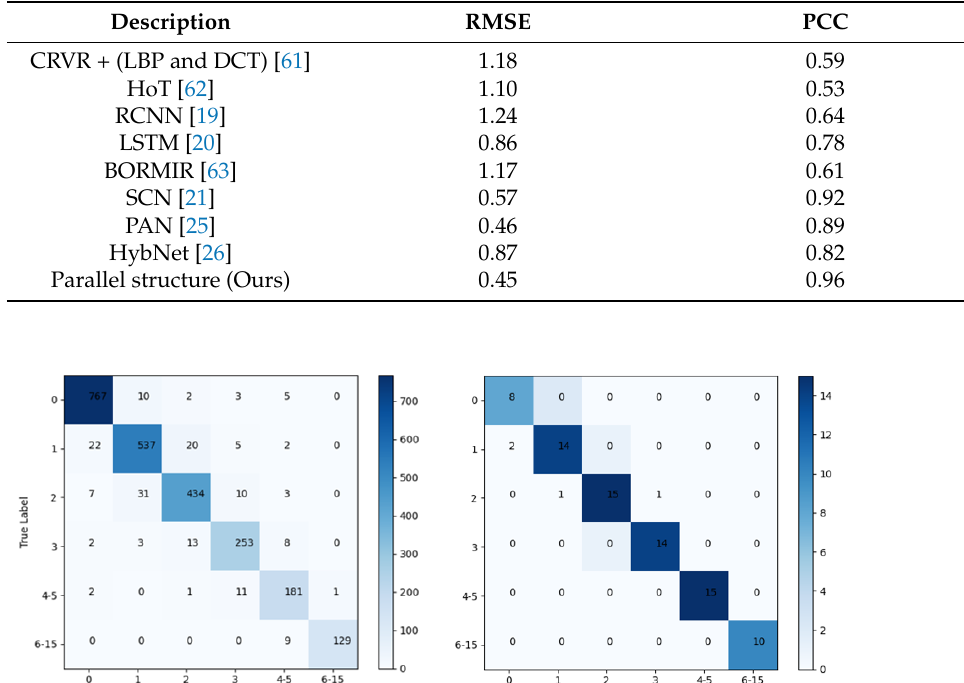
Figure 10. The comparison of the prediction and ground truth for an 80-frame video with pain ex- pression.